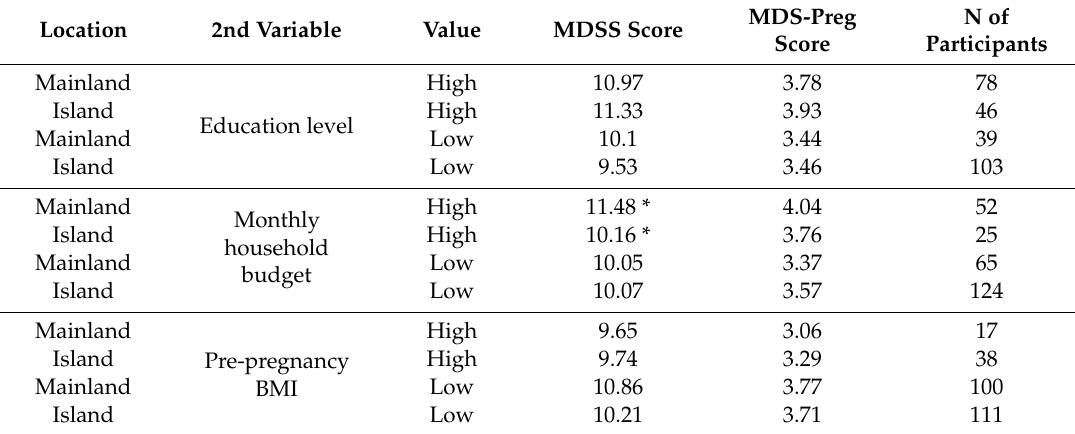
Table 4. Adherence to the Mediterranean diet according to two Mediterranean diet scores (* p <